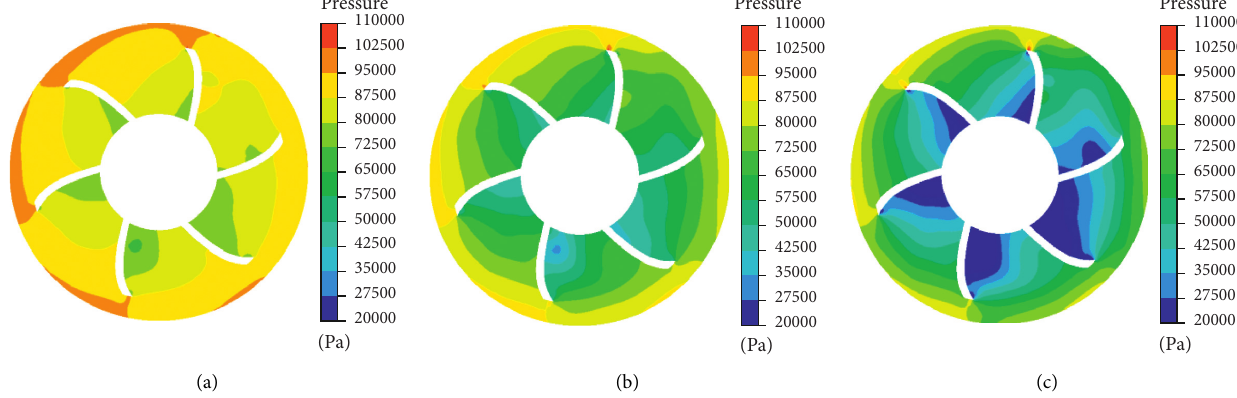
4.54.64.74.84.95.05.1 m ( H Figure 3: Efficiency, head, and meshes number Figure 4: Pressure distributions of z � 0 plane: (a) 1000r/min (80m 3 /h); (b) 1500r/min (120m 3 /h); (c) 2000r/min (160m 3 /h).